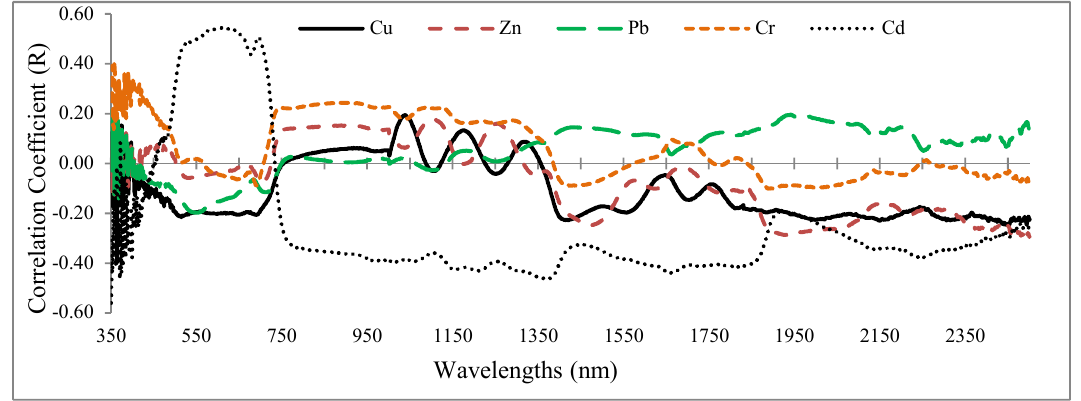
Figure 3. Correlation coefficient between the heavy metal concentration (determined by laboratory analysis) and spectral response of grapevine leaf samples (350 to 2500 nm).